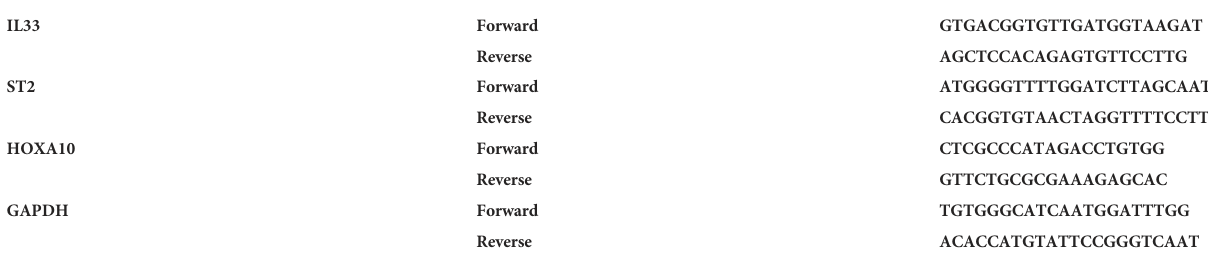
TABLE 2 Primer Sequences for qPCR.